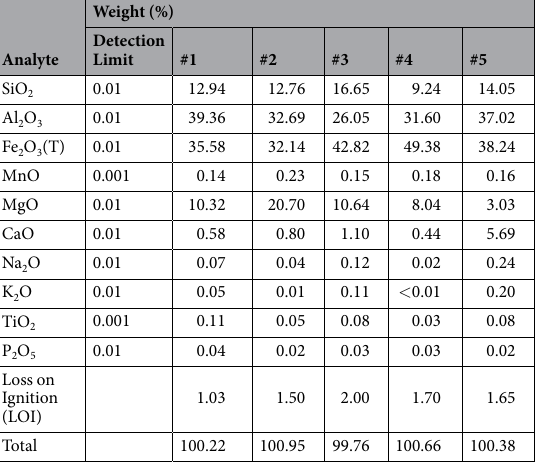
Table 1. Representative bulk composition of 5 SHS-treated slag samples analyzed by Fusion Inductively Coupled Plasma (FUS-ICP).